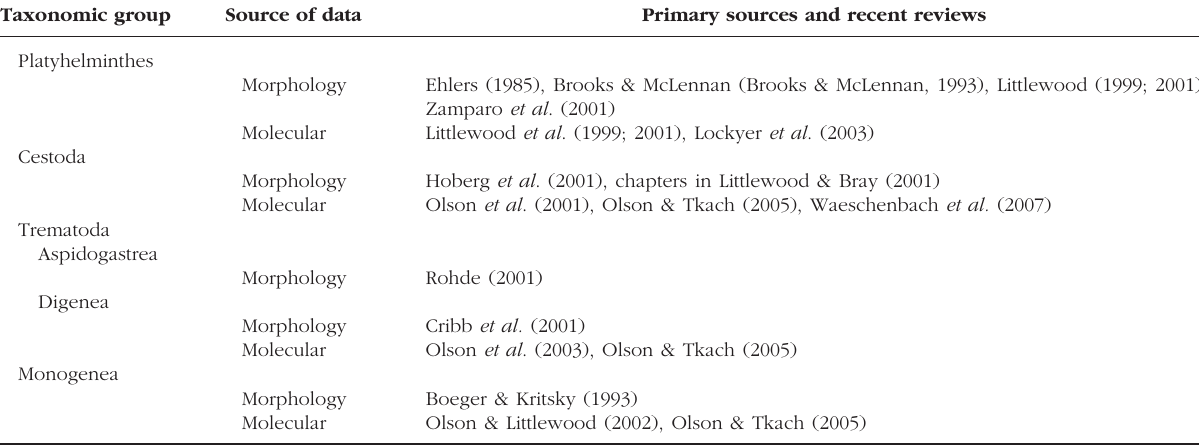
Table I. – Primary sources and recent reviews on phylogenetic estimates of major flatworm groups and their constituent